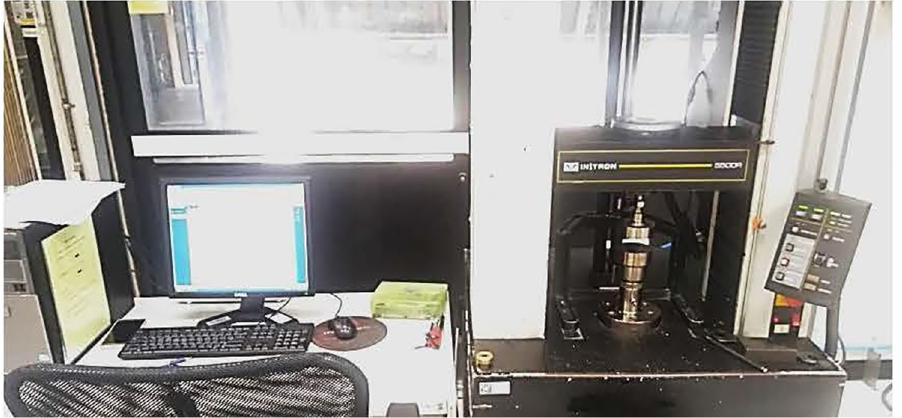
Fig 10. Tensile system test